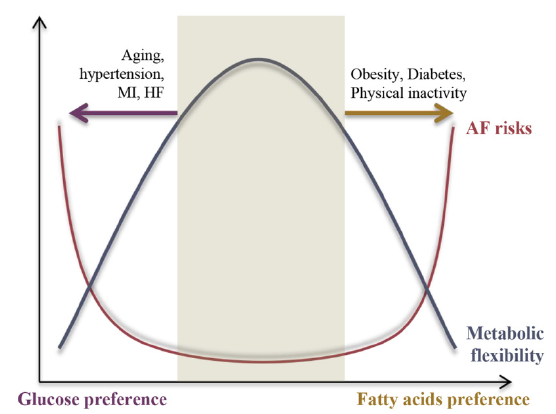
Figure 2. A negative correlation between the AF risk and cardiac metabolic flexibility.